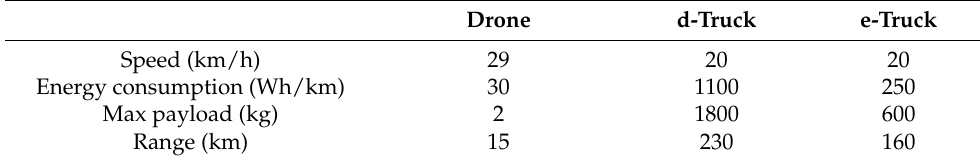
Table 4. Technical Features of the vehicles